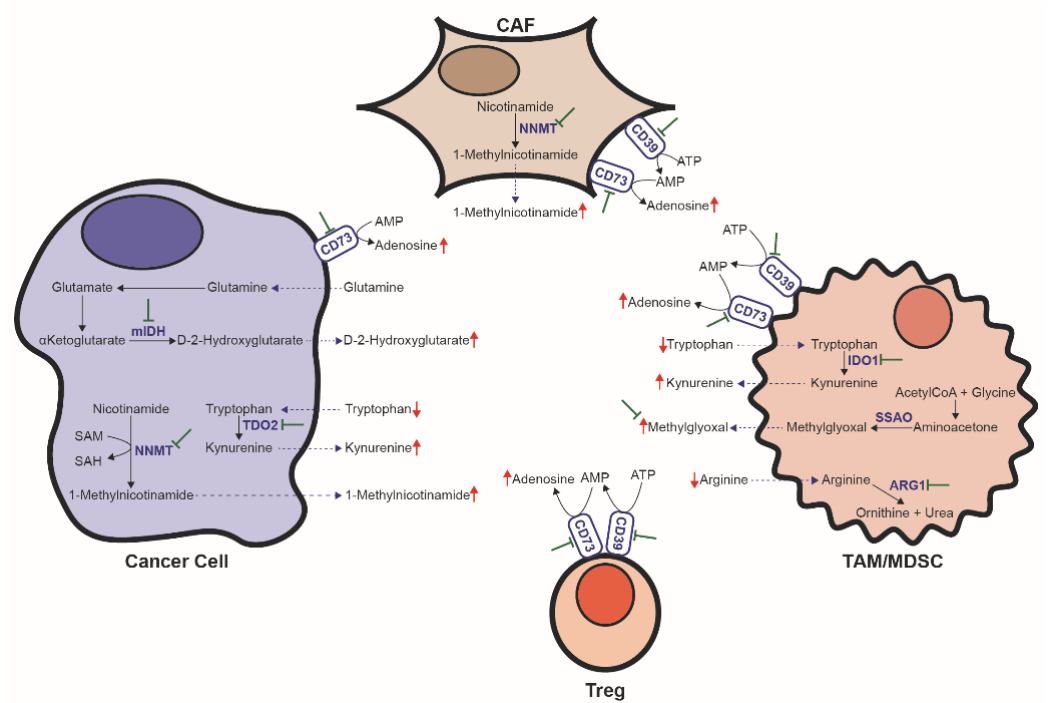
Figure 3. Metabolic activities contributing to immune suppression in the tumor microenvironment. Metabolic activities depleting key nutrients include arginine degradation by ARG1 and tryptophan degradation by IDO1/TDO2. Metabolic activities producing immunosuppressive metabolites include 1-MNA production by NNMT, kynurenine synthesis from tryptophan by IDO1/TDO2, D-2HG synthesis by mIDH1/2, adenosine production from ATP/AMP by the combined activ- ities of CD39 and CD73 and production of methylglyoxal by SSAO. CAF: cancer-associated fibroblast; TAM: tumor-asso- ciated macrophage; MDSC: myeloid-derived suppressor cell. mIDH: mutant isocitrate dehydrogenase. TDO2: tryptophan-